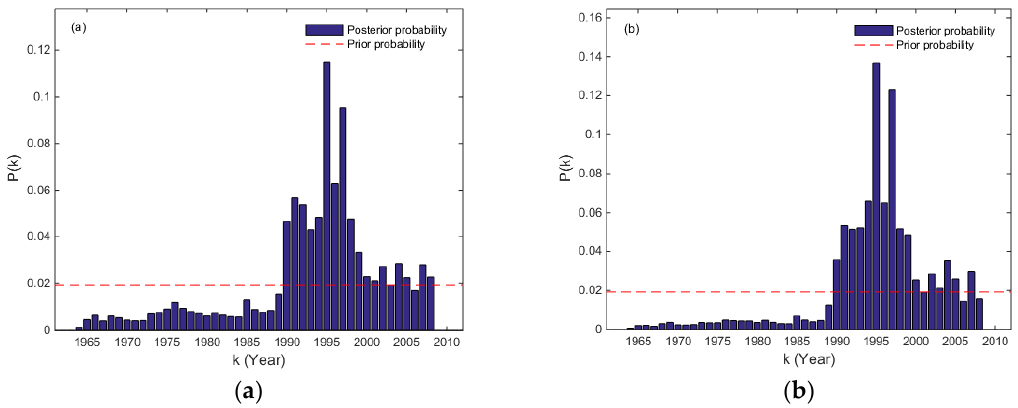
Figure3. The abrupt Bayesian analysis of precipitation ( a ) and runoff ( b ). Figure 3. The abrupt Bayesian analysis of precipitation ( a ) and runoff ( b ).